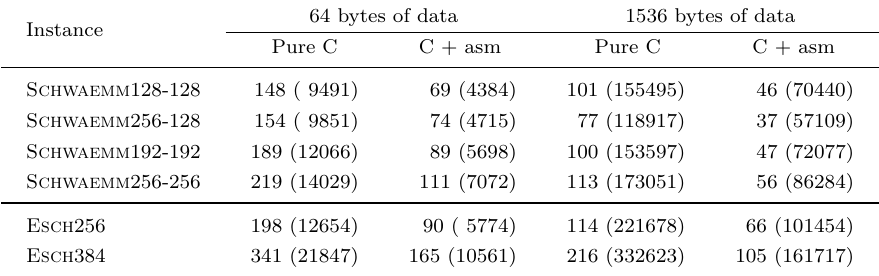
Table 14: Benchmarking results for the different instances of Schwaemm and Esch on an ARM Cortex-M3 microcontroller when processing 64 and 1536 bytes of data, respectively (in the case of Schwaemm the benchmarked operation is encryption and the length of the associated data is 0). The results are given in cycles/byte, with the number inside parentheses representing the total cycle count for processing the specified amount of